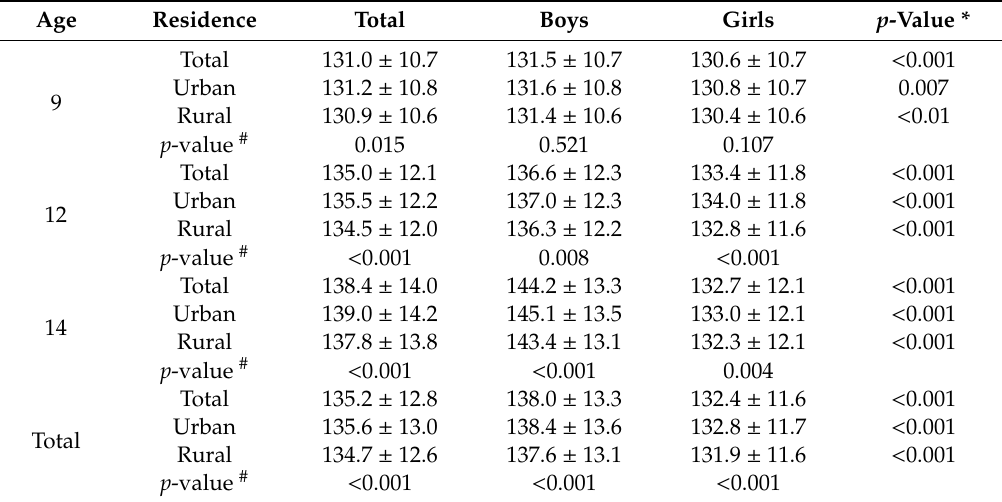
Table 2. The mean hemoglobin concentration in 9-, 12-, and 14-year-old children, by sex and residence area.